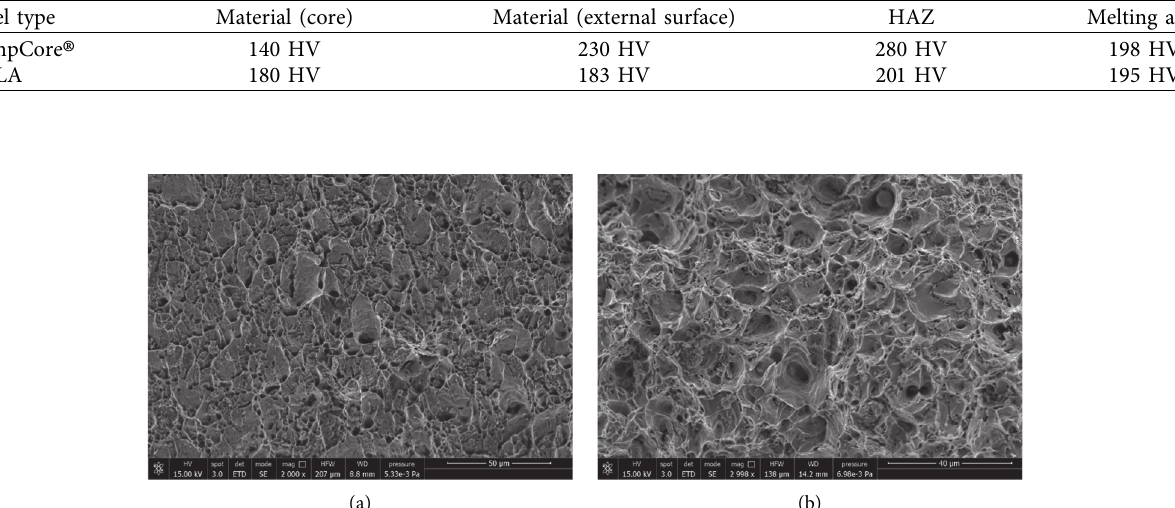
Table 5: Results of hardness tests (average values on three specimens).